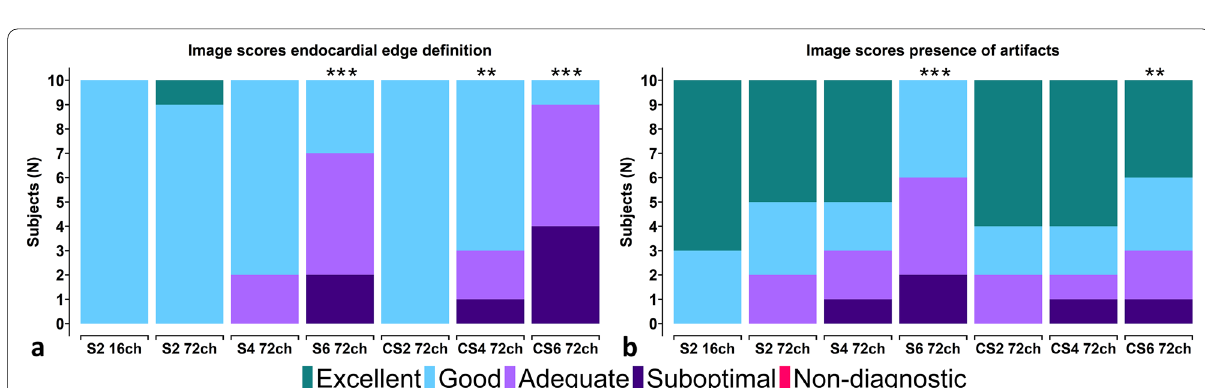
Fig. 4 Stacked bar charts of combined averaged image quality scores by the two independent observers. All slices in diastole and systole per subject are averaged where colours depict an image quality score of excellent (green), good (light blue), adequate (light purple), suboptimal (dark purple), or non-diagnostic (red) in each grading criteria based on ( a ) endocardial edge definition and ( b ) presence of artifacts. * p < 0.05, ** p < 0.01, *** p < 0.001